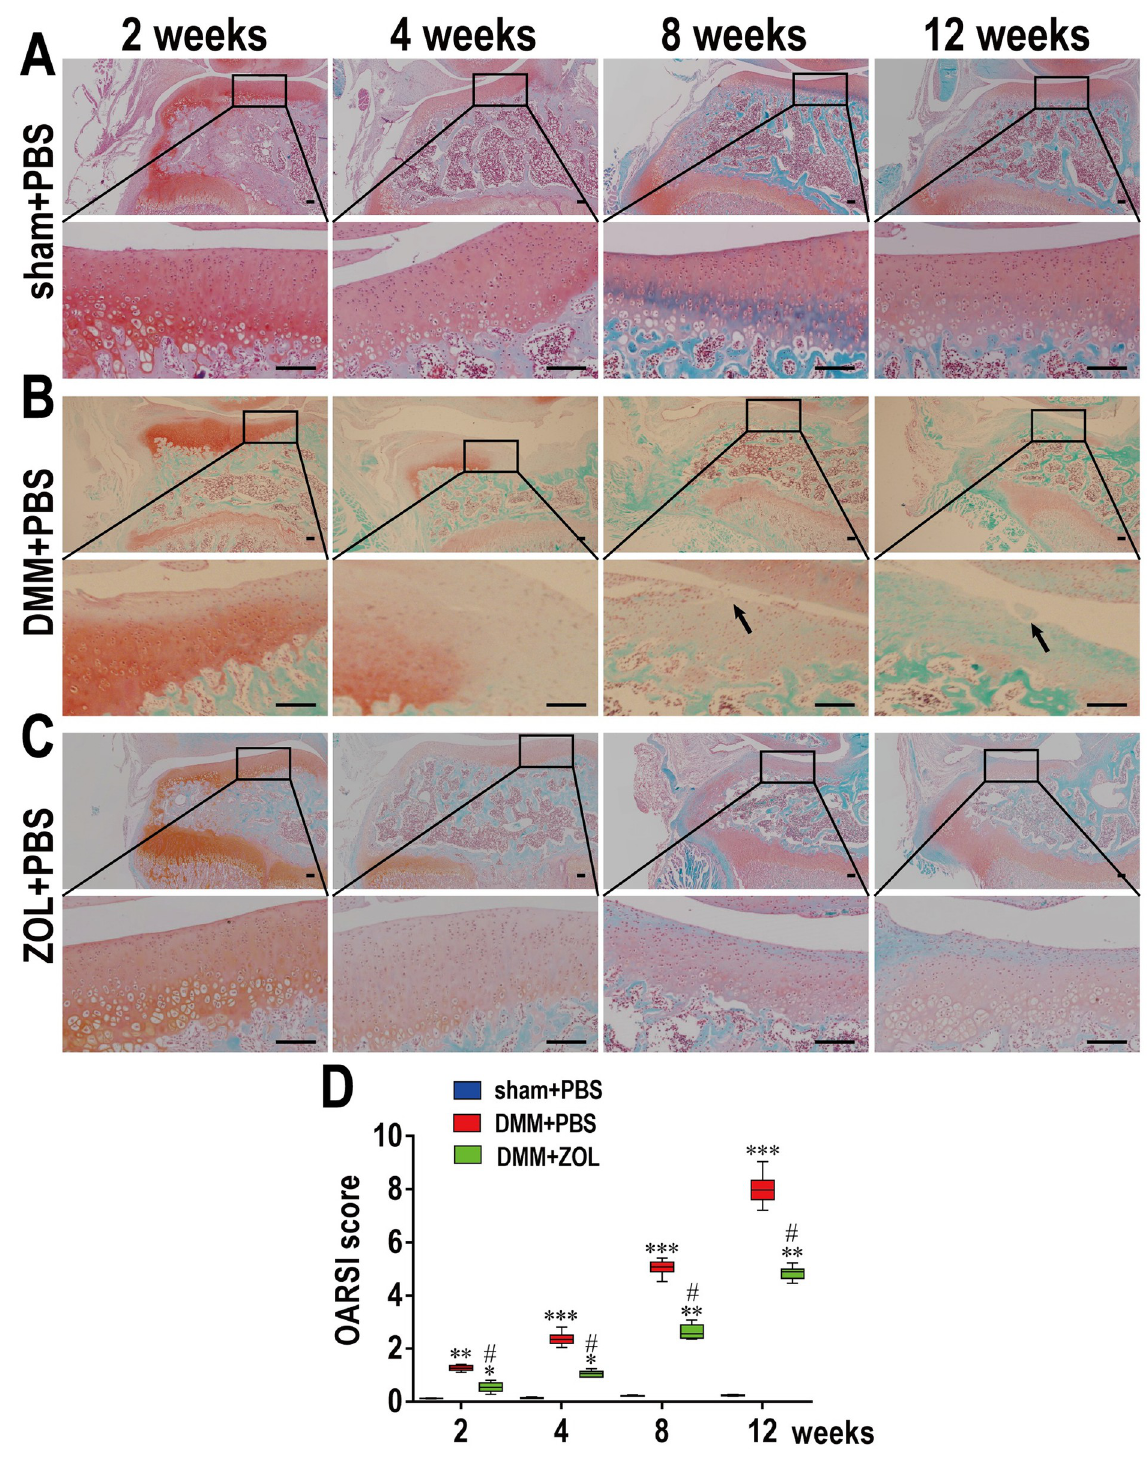
Fig 4. ZOL attenuates articular cartilage degeneration in DMM-induced OA rats. Histological analysis of articular cartilage stained with (A, B and C) Safranin O-fast green in coronal sections of tibia at various time-points. Scale bar, 100 μ m. Quantitative analysis of (D) OARSI scores at various time-points (n = 6 per group/time point). � P < 0.05, �� P < 0.01, and ��� P < 0.001, compared with sham+PBS group; # P < 0.05, compared with DMM+PBS group.